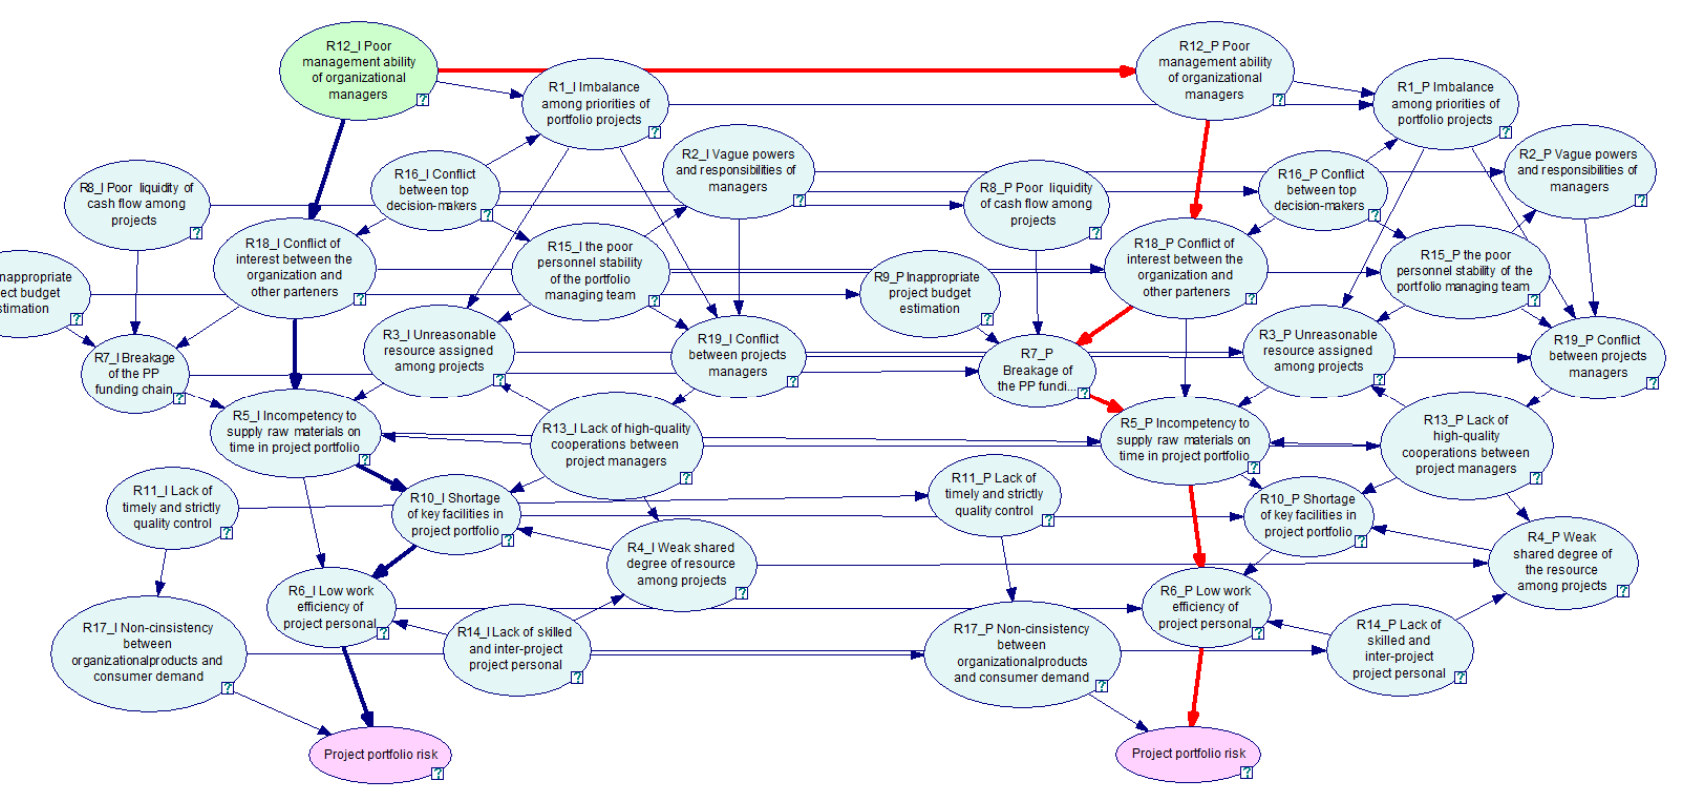
Figure 5. An instance of the risk contagion path of “ R 12